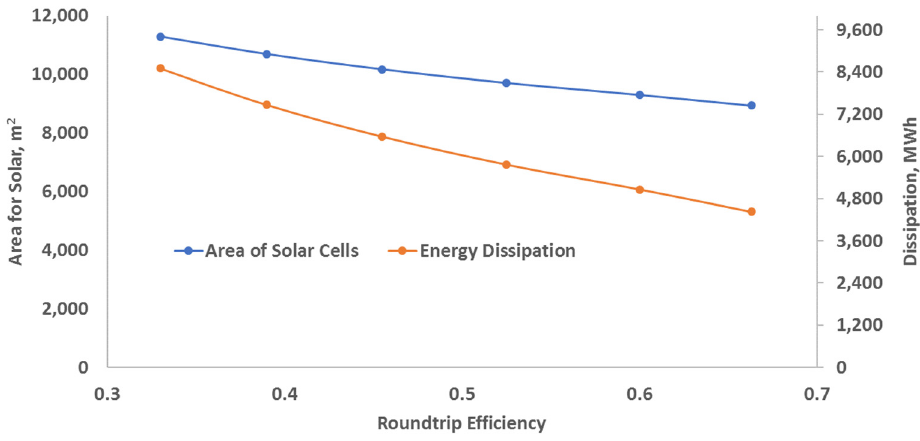
Figure 5. Effect of storage component efficiency on area needed for solar arrays, in m 2 , and energy dissipated in the system, in MWh.